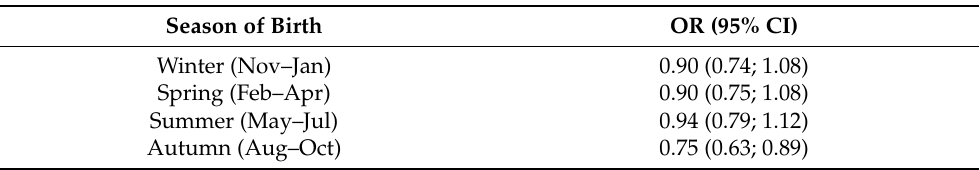
Table 4. Odds for the season interaction effect, logistic regression model with adjustment for sex and exposure to vitamin D fortification